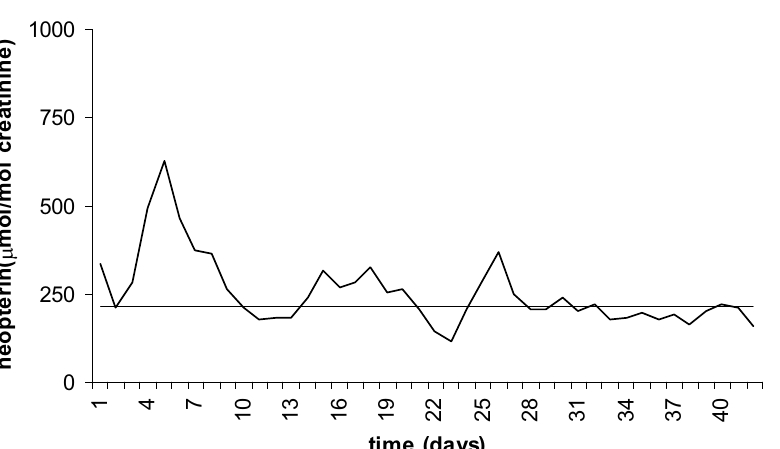
Figure 1. A 64-year-old woman with history of bilateral breast carcinoma and recurrent EOC presented with sec- ond recurrence of EOC that manifested as ascites. The patient was treated with the combination of paclitaxel (175 mg/m 2 ) and carboplatin (area under the curve 6) every 3 weeks. Urinary neopterin was measured daily during the initial two cycles of therapy. Marked peaks of urinary neopterin were observed in the first week after adminis- tration of each dose of chemotherapy on days 0 and 22, but initially increased urinary neopterin concentrations gradually declined to normal range (from 333 to 156 µ mol/mol creatinine). Serum CA125 concentrations declined during the same period from 2323 to 104 U/ml, and decreased to normal range during subsequent cycles of therapy. The urinary neopterin concentration of 213 µ mol/mol creatinine defined as upper limit of normal in an earlier study is indicated by a line (4).